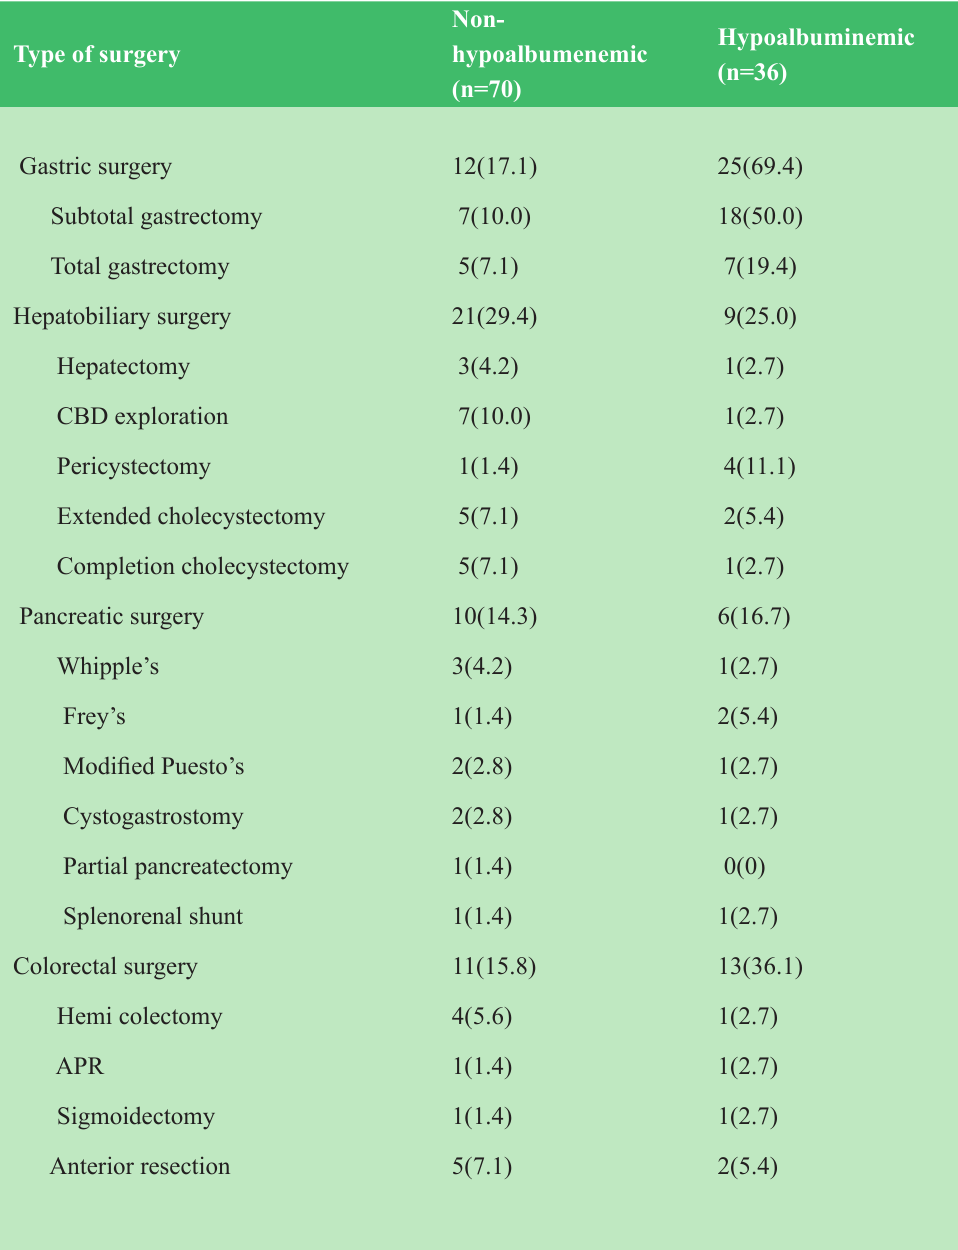
Table 2: Type of surgery on Nonhypoalbuminemic and Hypoalbuminemic